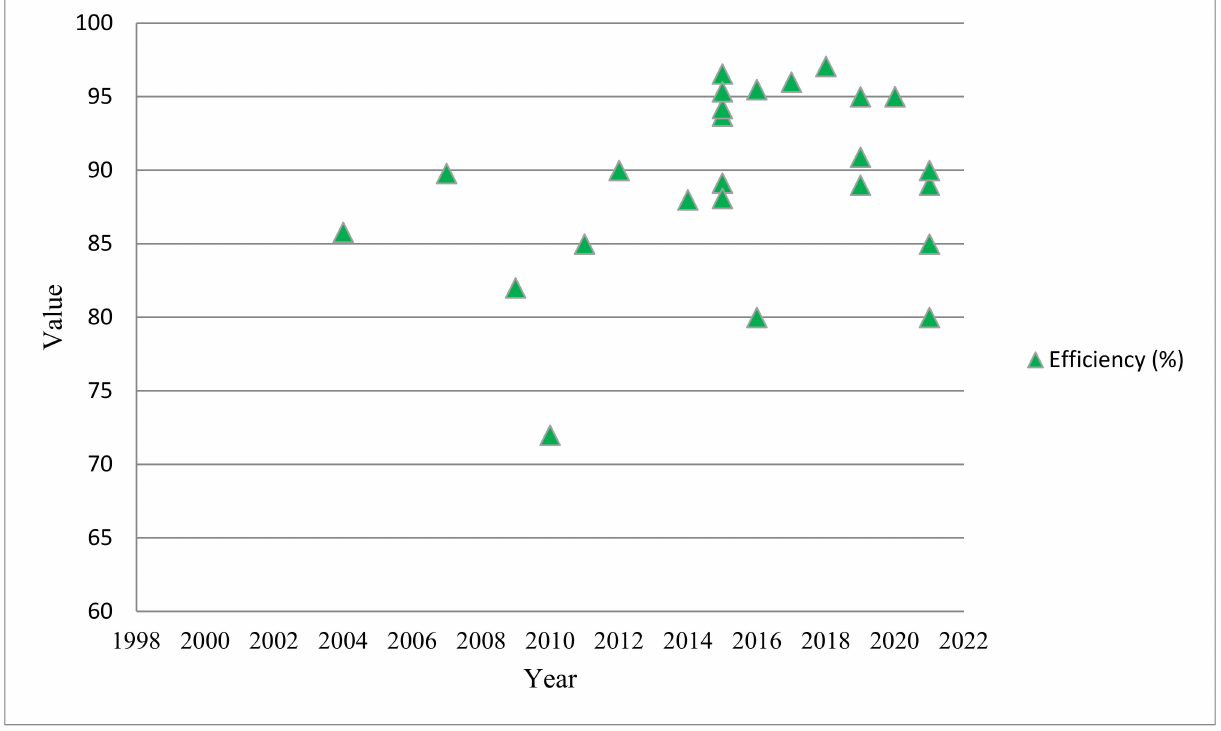
Figure 10. Efficiency values used in academic studies by years of